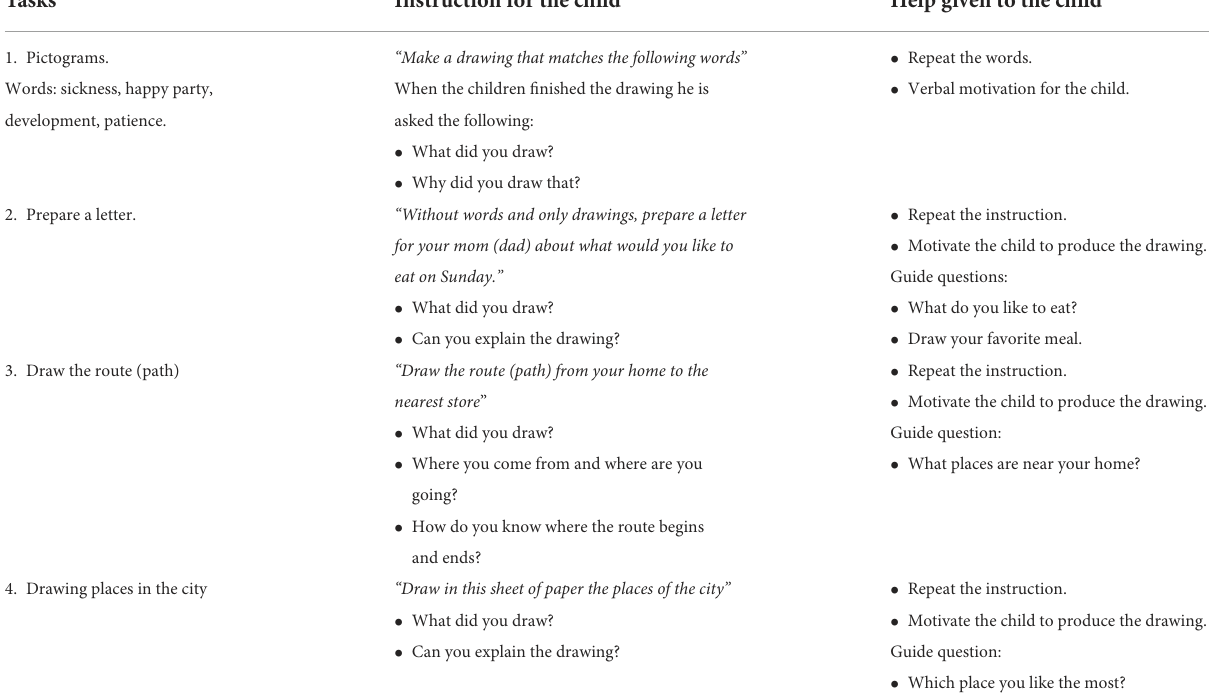
TABLE 1 Tasks applied for the assessment of symbolic perceptual actions.